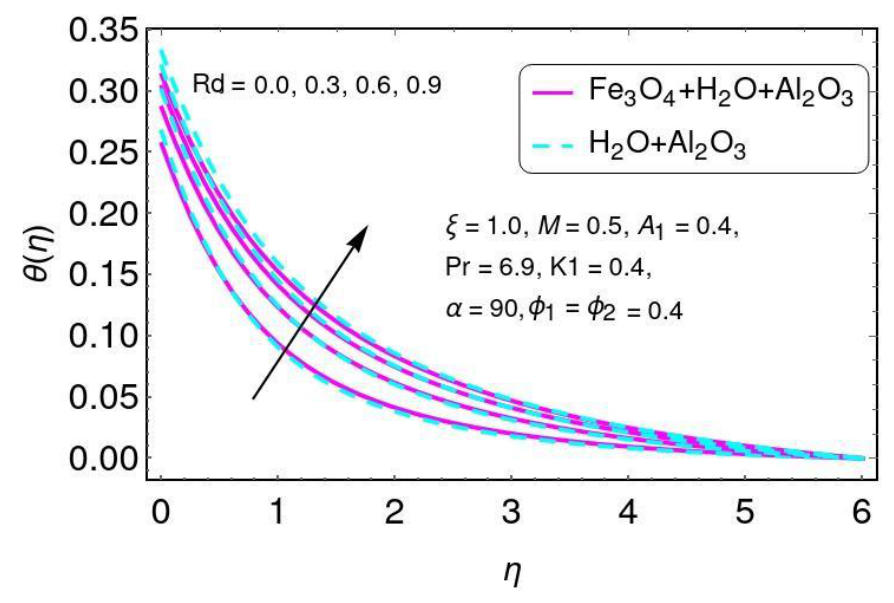
Figure 7. The impact of R for θ ( η )